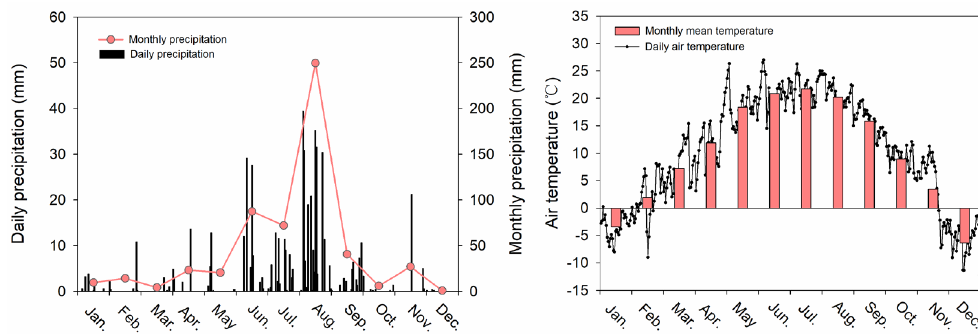
Figure 5. Monthly and daily precipitation and temperature in 2020.